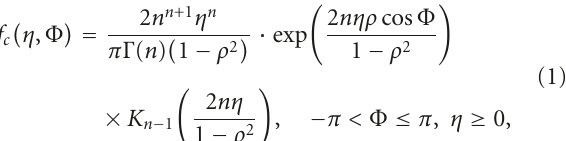
Because the PDF of (1) and (2) depend only on the number of looks and the coherence, the KL divergence are plotted in Figure 1 as a function of the two parameters using numerical integration. For 0 < ρ ≤ 1 and 0 < n ≤ 25 in the figure, it is clear that η and Φ are not statistically independent, where the KL divergence become large as the coherence increase and the looks number decrease. As the KL divergence of (3) shown in Figure 1, the interferometric magnitude and phase cannot be assumed to be independent for most